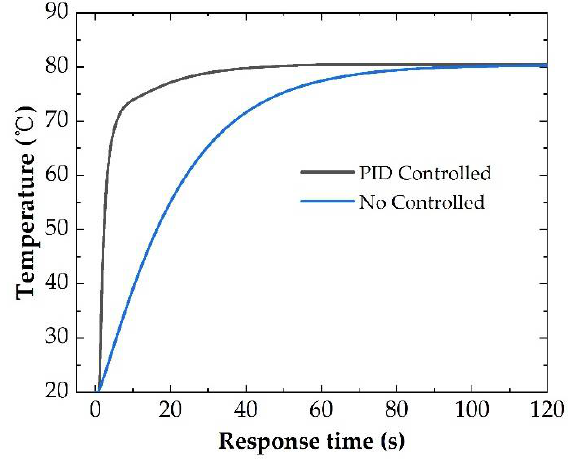
Figure 9. The response time of the microheater with and without PID control.